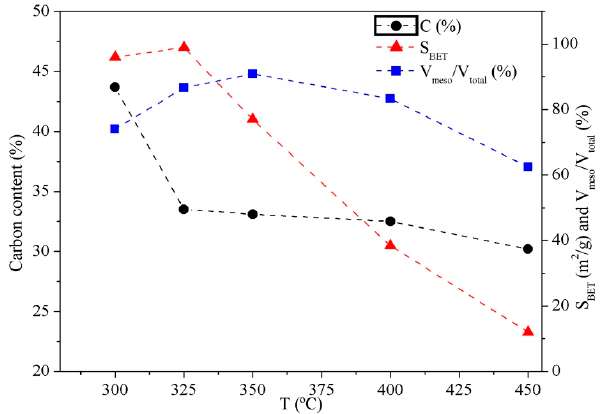
Figure 3. Carbon content on an ash-free basis, surface area ( S BET ), and V meso / V total ratio of the hydrochar